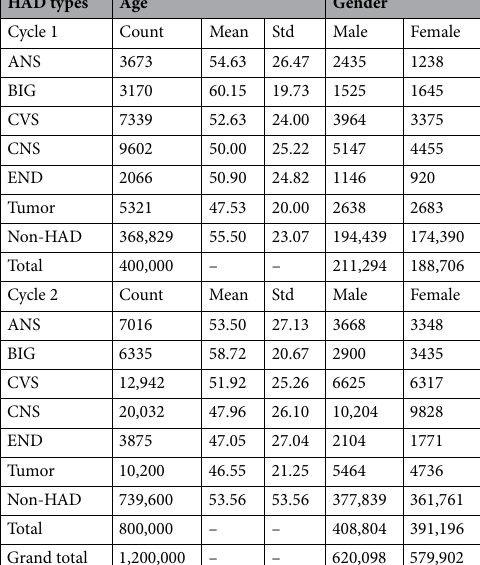
Table 6. HAD type distribution in IPD data set.